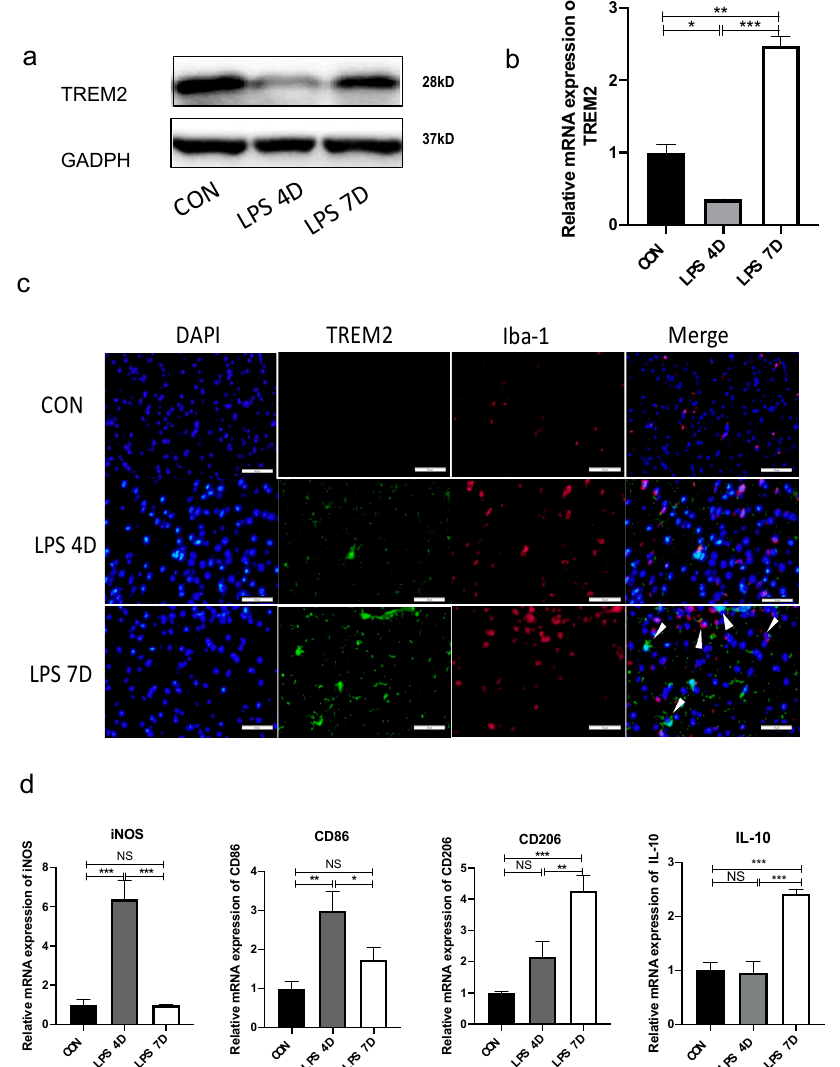
Figure 1. LPS reduced TREM2 expression and changed the polarization of microglia in vivo. ( a ) Protein levels of TREM2 showed opposite trends of these groups by Western blot. ( b ) mRNA expression of TREM2 in each group of mice by PCR. ( c ) Immunofluorescence staining of brain sections from each group of mice. Iba-1 indicates activated microglia (Red). ( d ) mRNA expression of M1-type microglia markers (iNOS and CD86) and M2-type microglia markers (CD206 and IL-10) by PCR. NS indicates no statistical difference from the control group. * p < 0.05, ** p < 0.03, *** p < 0.01 compared with control, n = 6 mice per group.